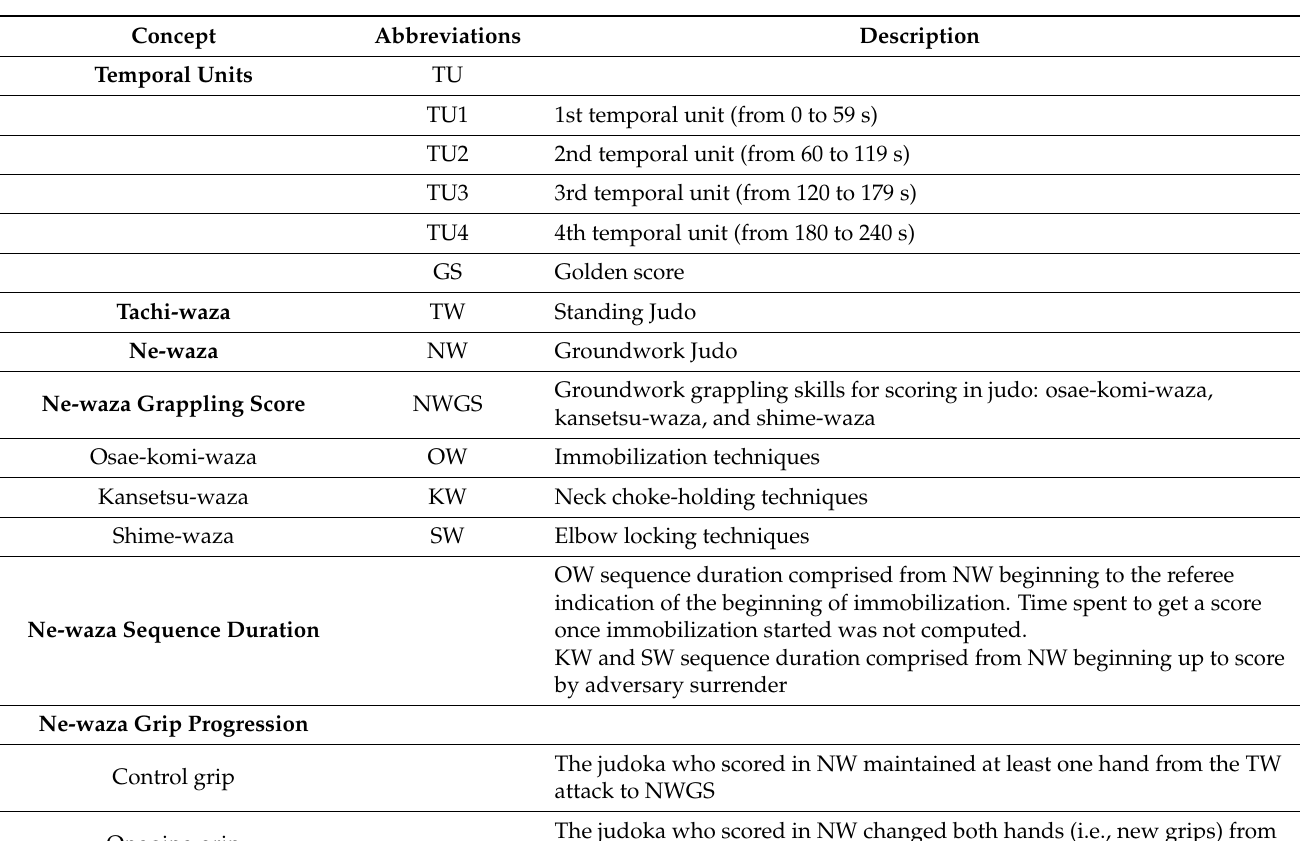
Table 1. Observational instrument of the